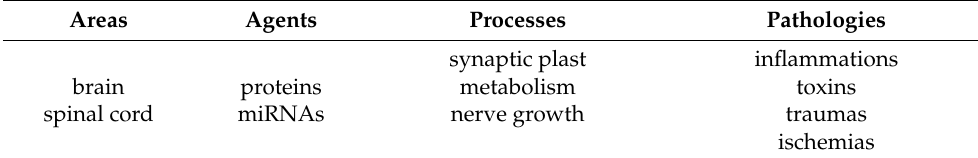
Table 1. Effects induced by fusion of MSC-EVs to neurons and glial cells and tissues. Areas Agents Processes Pathologies synaptic plast brain proteins spinal cord nerve